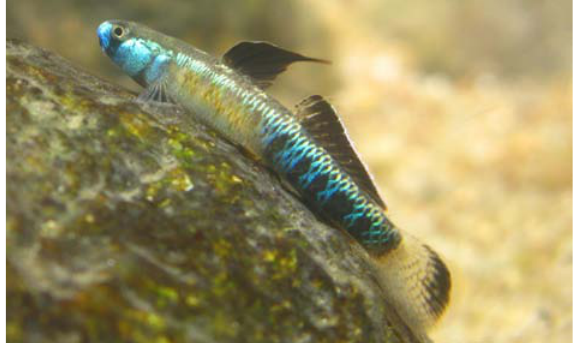
Image 15 Stiphodon multisquamus (female) with light blue